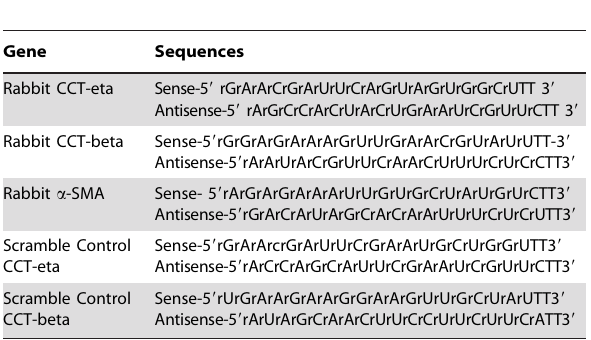
Table 1. List of siRNA sequences used to target the genes of